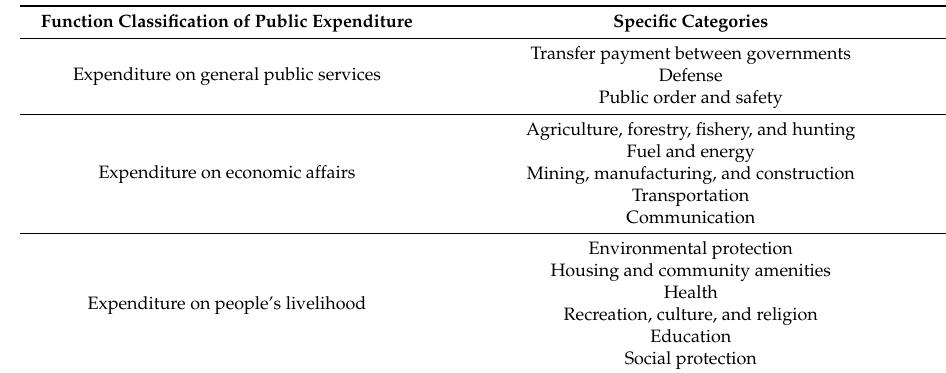
Table 1. Detailed categories of